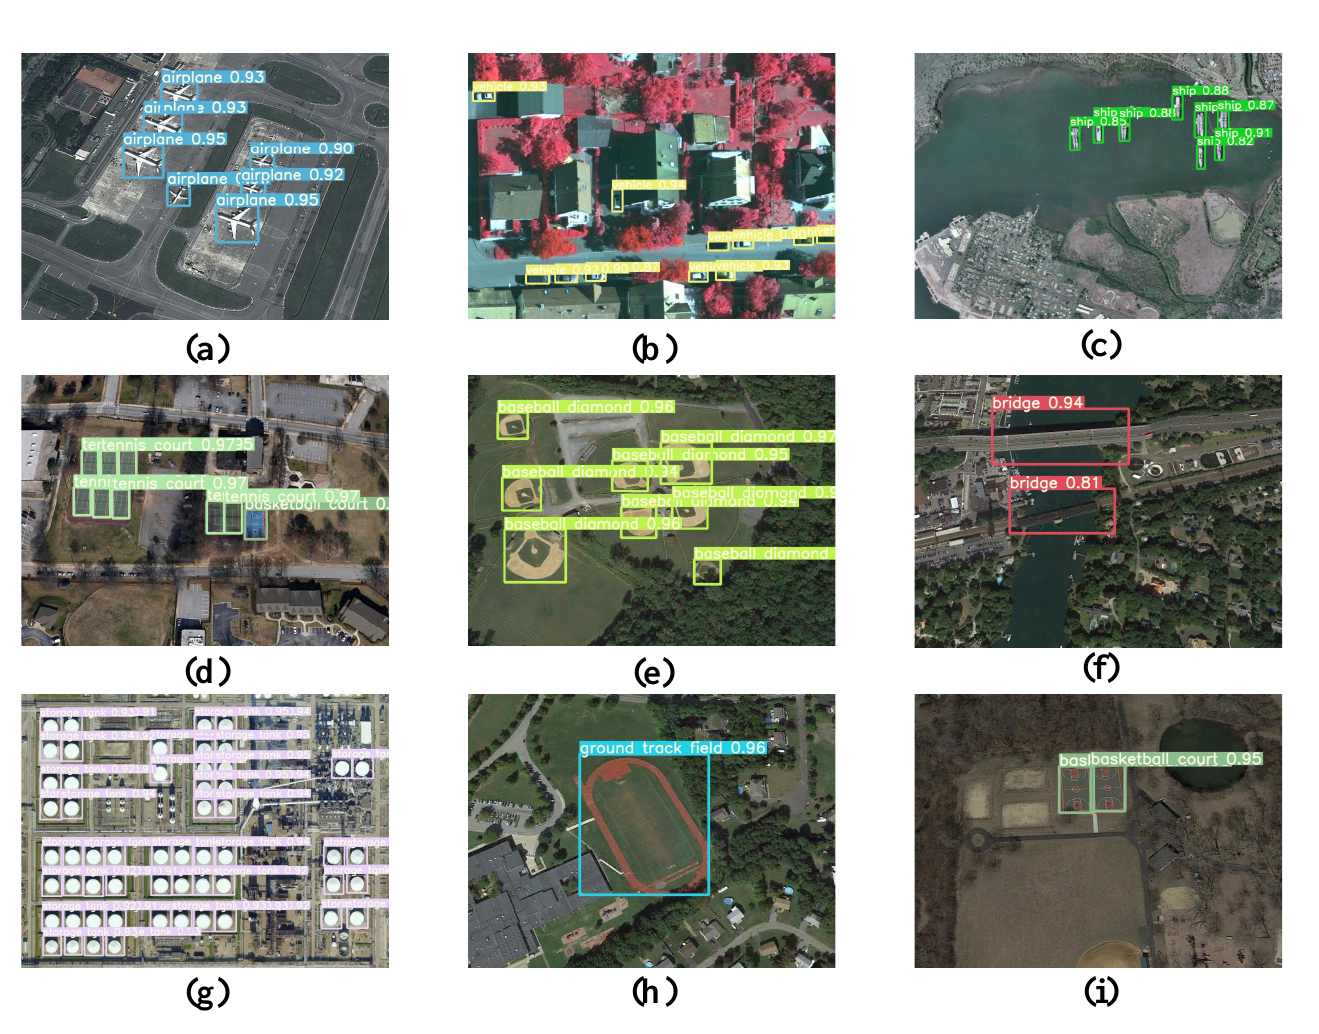
Figure 13. There are some detection results of the KCFS-YOLOv5 on the NWPU VHR-10 dataset. ( a ) is the airplane, ( b ) is the vehicle, ( c ) is the ship, ( d ) is the tennis court, ( e ) is the baseball diamond, ( f ) is the bridge, ( g ) is the storage tank, ( h ) is the ground track field, and ( i ) is the basketball court. Table 11. Comparison of the KCFS-YOLOv5 with other advanced algorithms on the RSOD